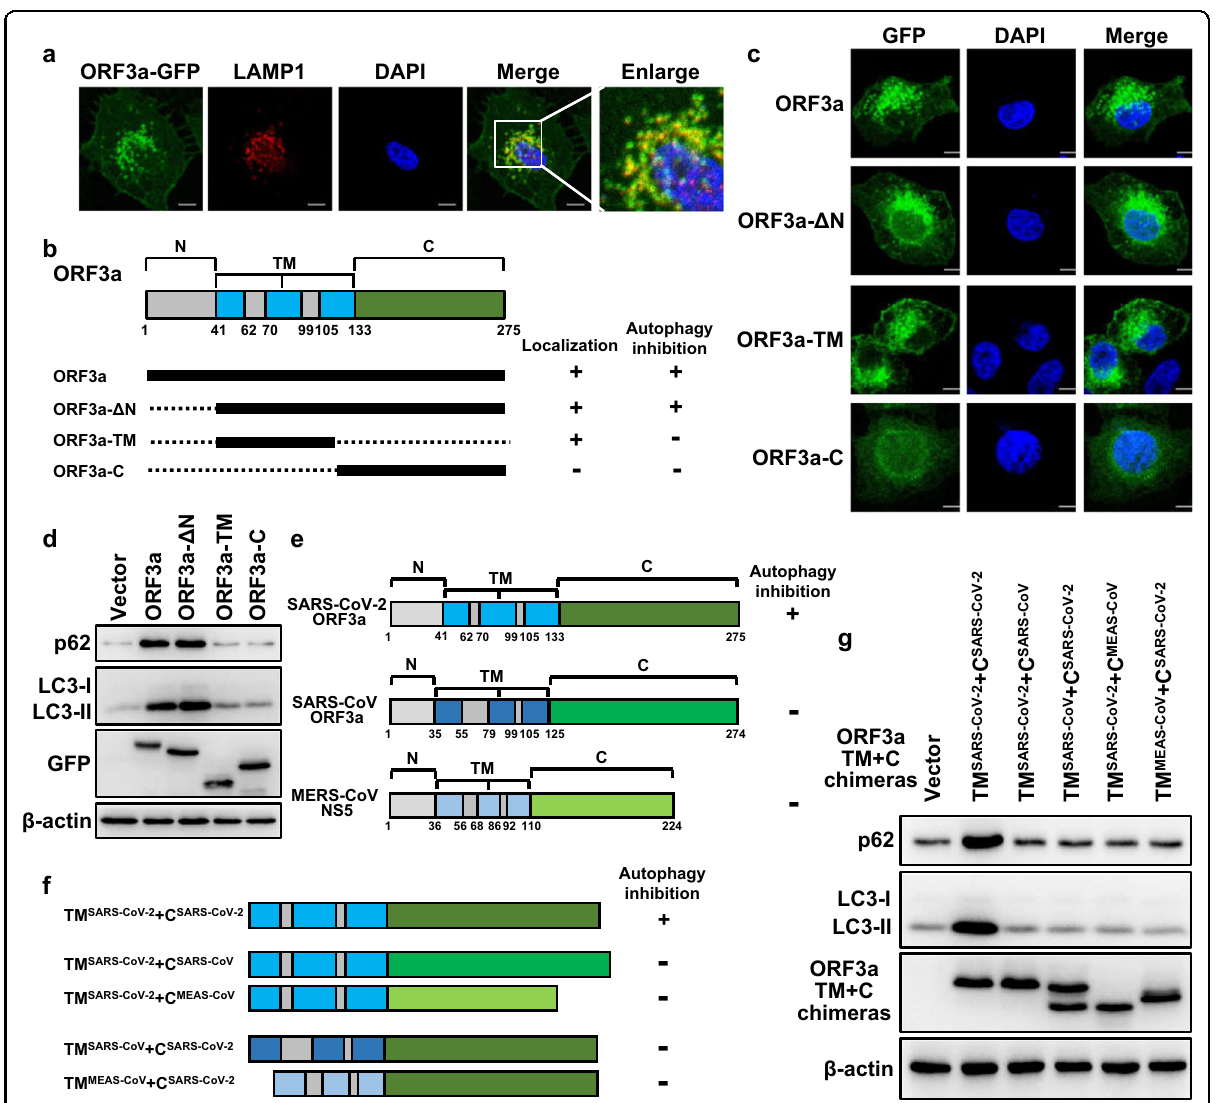
Fig. 4 The TM domain and C-terminus are important for ORF3a-mediated blockade of autophagy. a ORF3a colocalized with lysosome. ORF3a- GFP was expressed in HeLa cells, and lysosomes were visualized by immuno fl uorescence with an anti-LAMP-1 antibody. Scale bars, 0.5 μ m. b Schematic representation of ORF3a and the indicated truncated mutant used to determine the cellular localization and function of ORF3a in autophagy. c Fluorescence of GFP-tagged ORF3a and the indicated truncated mutants in HeLa cells. Scale bars, 0.25 μ m. d ORF3a and the indicated truncated mutants were expressed in HeLa cells, and their effect on autophagy was analyzed by detecting the protein levels of p62 and LC3. e Schematic representation of the protein domains of ORF3a homologs in β -coronaviruses (SARS-CoV-2, SARS-CoV, and MERS-CoV). f Schematic representation of chimeras of the SARS-CoV-2 ORF3a TM domain with a C-terminus from an ORF3a homolog or the SARS-CoV-2 ORF3a C-terminus with a TM domain from an ORF3a homolog. g SARS-CoV-2 ORF3a TM + C-terminal truncated mutant or the indicated chimeras were expressed in HeLa cells, and their effect on autophagy was analyzed by measuring the protein levels of p62 and